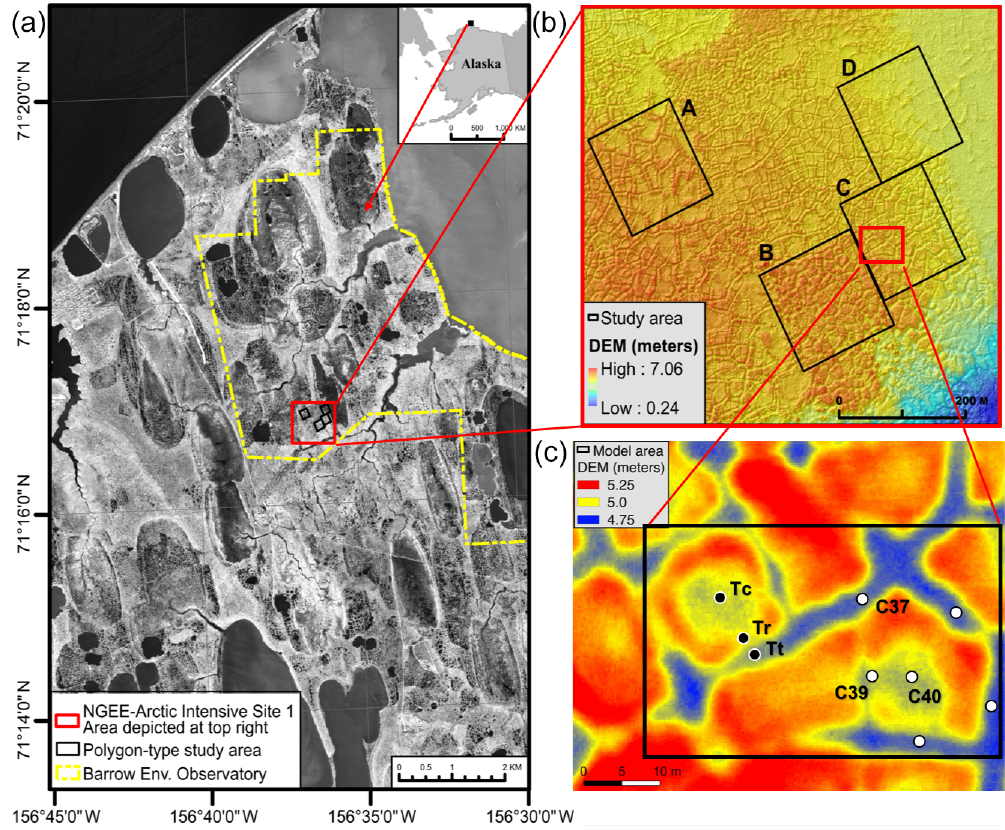
Figure 1. Next-Generation Ecosystem Experiments – Arctic field sites at the Barrow Environmental Observatory. The model area lies in Area C outlined in black in (c) . Wells and thermistor probe locations are highlighted in white and black, respectively. Data from wells and temperature probes used for model evaluation are labeled as C37 (trough), C39 (center), C40 (center) and vertical thermistor probes Tt (trough), Tc (center), and Tr (rim). The digital elevation model (DEM) in (b) and (c) is derived from lidar measurements (Wilson and Altmann,